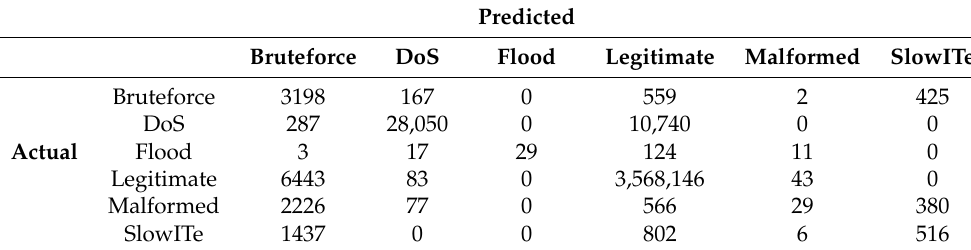
Table 6. Confusion matrix neural network.